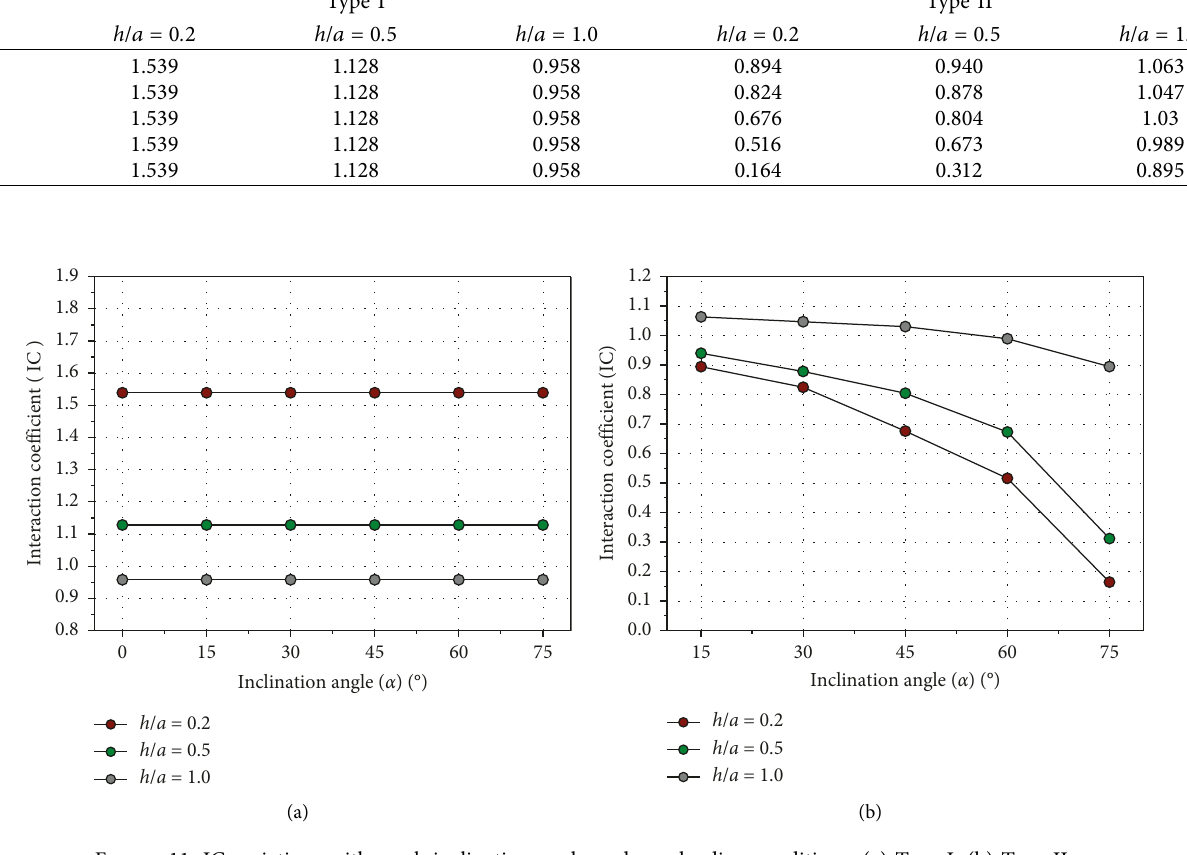
Figure 11: IC variations with crack inclination angle under unloading conditions. (a) Type I. (b) Type